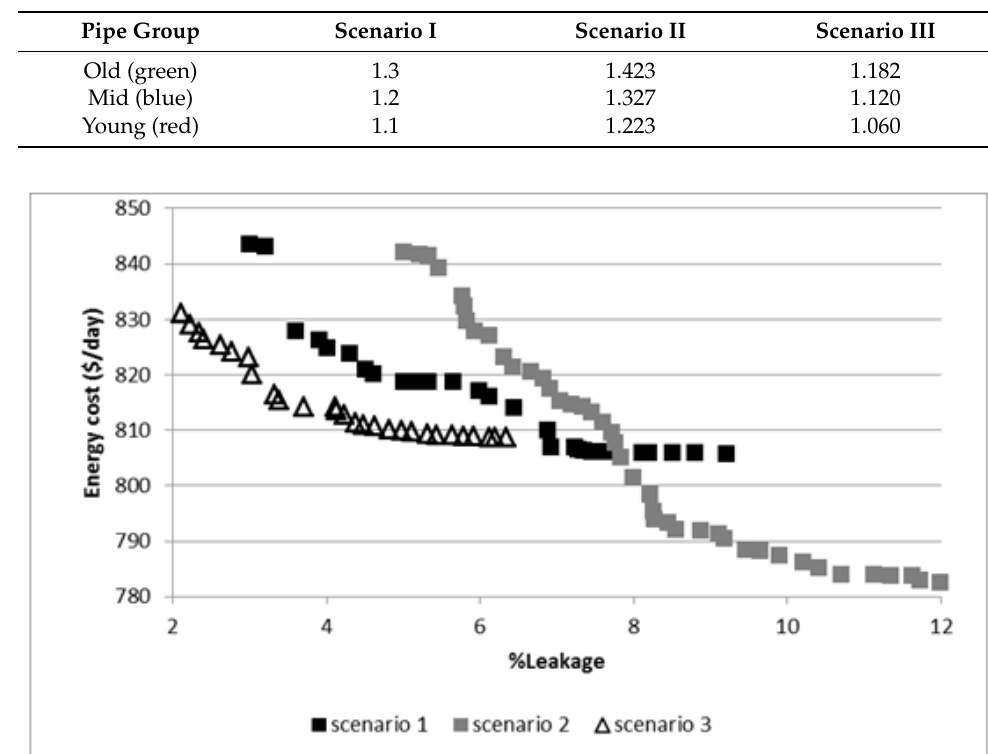
Figure 12. Solutions for different values of α 4.